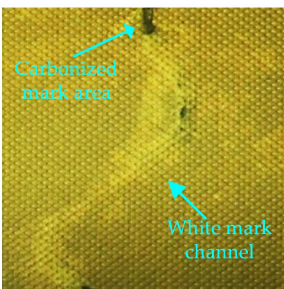
Figure 1. The white mark and carbonized mark on pressboard